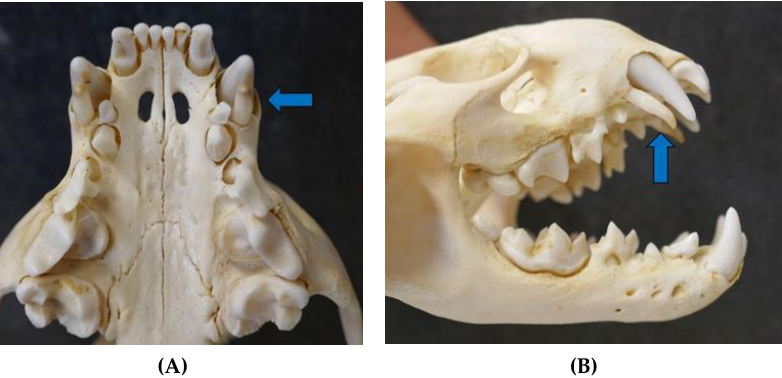
Figure 6. Erupted permanent teeth and deciduous teeth (blue arrow) in a male otter cub from Schles- wig-Holstein (( A ) ventral view upper jaw and ( B ) lateral view skull). Protozoal cysts in the lingual musculature were found in six female (~0.5–5.5 years) and five male (~0.5–3.5 years) otters (see also 3.6 Parasitology). A male of unknown age showed both erosions and bleedings of the gastric mucosa, as well as ulcerative gastritis histologically. This was a reported roadkill. An adult female (2.4–4.5 years) with promi- nent tits and placental scars displayed lymphohistiocytic gastritis. Another female of un- known age that had reportedly died during veterinary care after vehicle collision had ero- sions of the gastric mucosa. A male cub that had died during rehabilitation after being found abandoned and emaciated had a submucosal gastric edema. The same animal suf- fered from acute purulent and necrotizing enteritis. Portal fibrosis occurred in the liver of one male (unknown age) and one female (2.5–4.5 years). The animals also suffered from granulomatous pneumonia and bronchopneumonia. The male otter displaying ulcerative gastritis also had cholelithiasis, associated with fibrosis, in its liver. Portal hepatitis was diagnosed in a female otter (0.5–2.5 years).